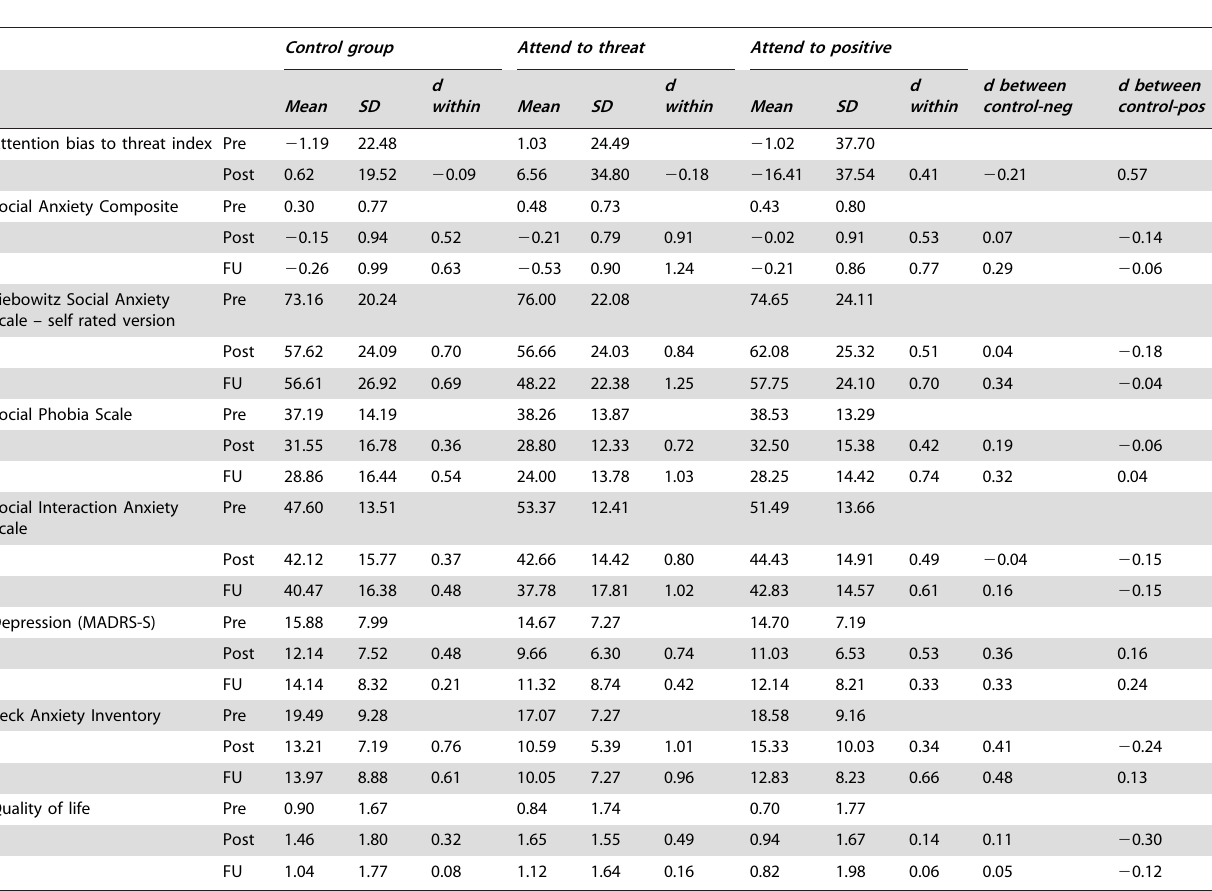
Table 2. Observed means, standard deviations, and effect sizes (Cohens) d of primary and secondary outcome.